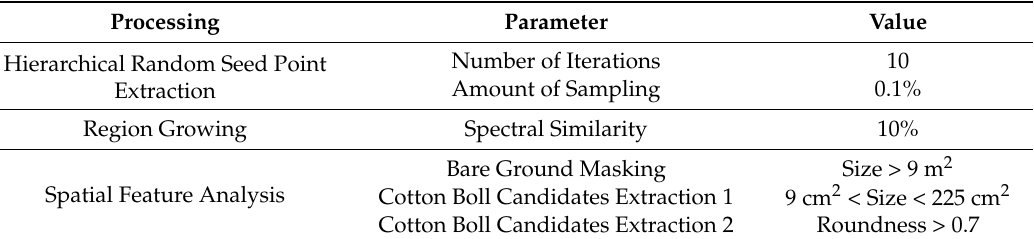
Table 1. Parameters in cotton boll candidate